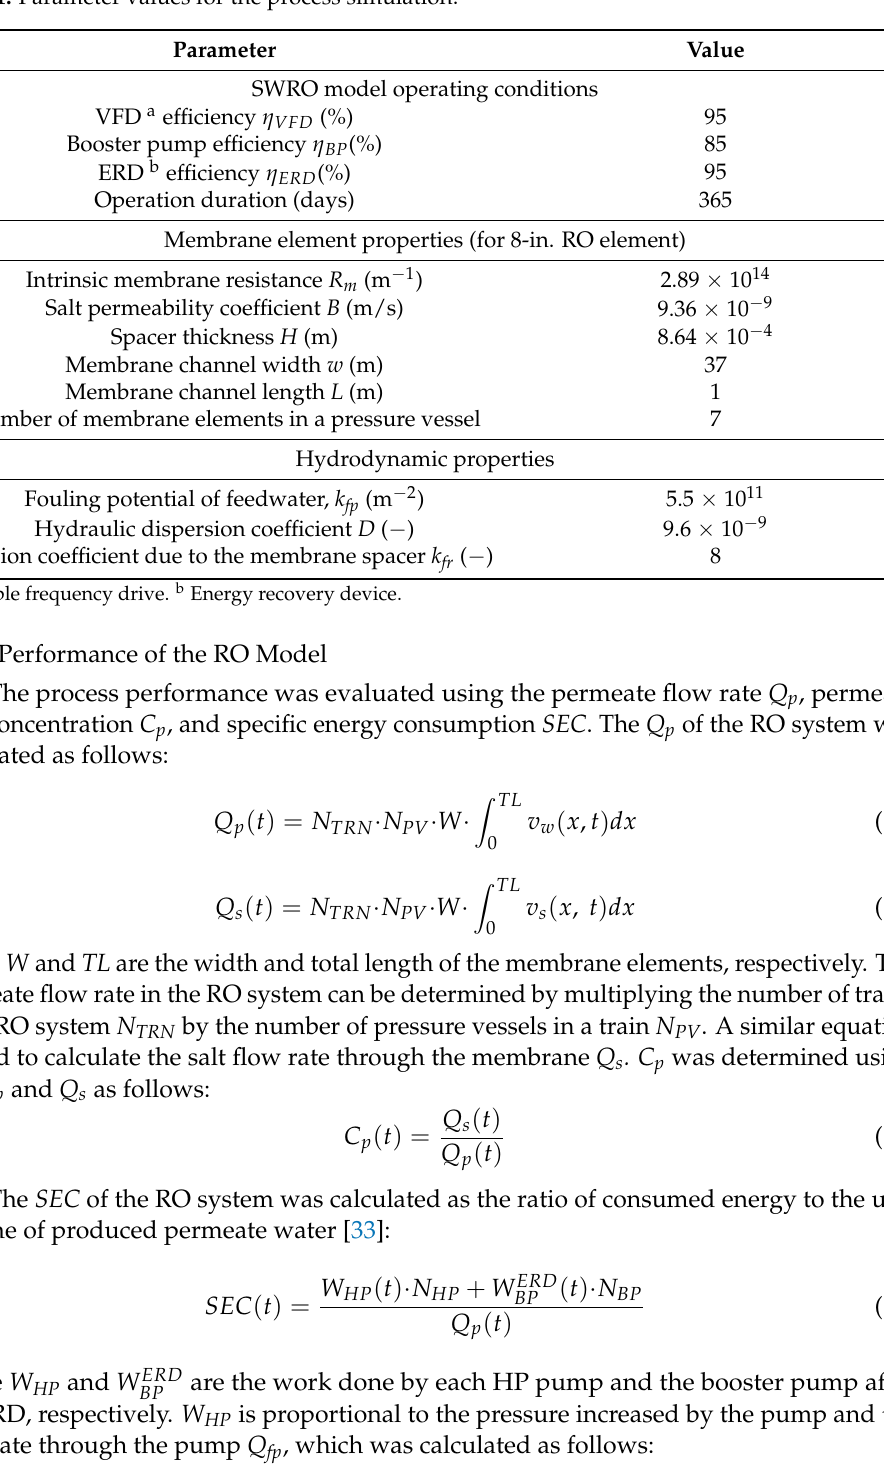
Table 1. Parameter values for the process